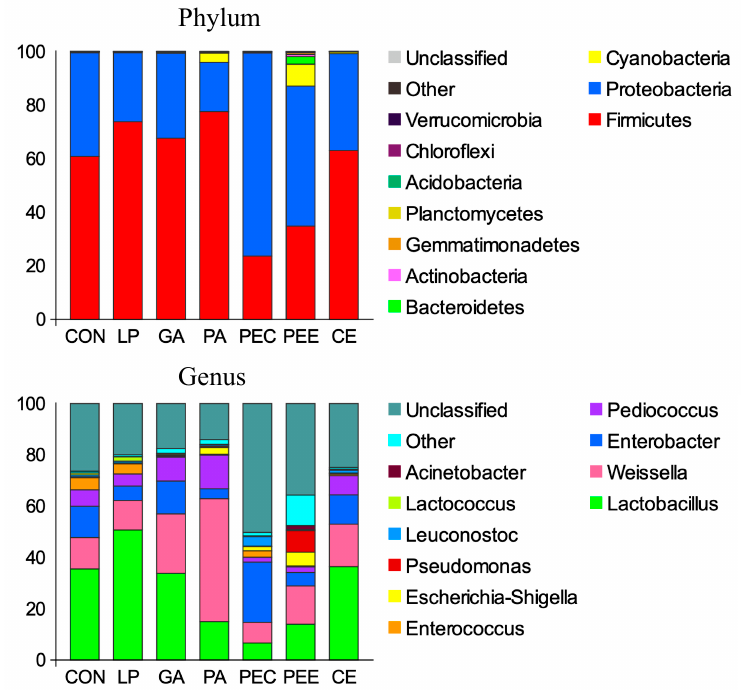
Figure 3. The relative abundance of bacteria community proportions at the phylum and genus level across the treatments (as a percentage of the total sequence).